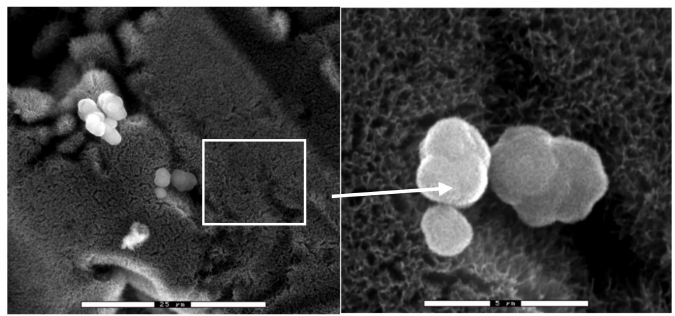
Figure 6. The first apatite nuclei appeared after 3